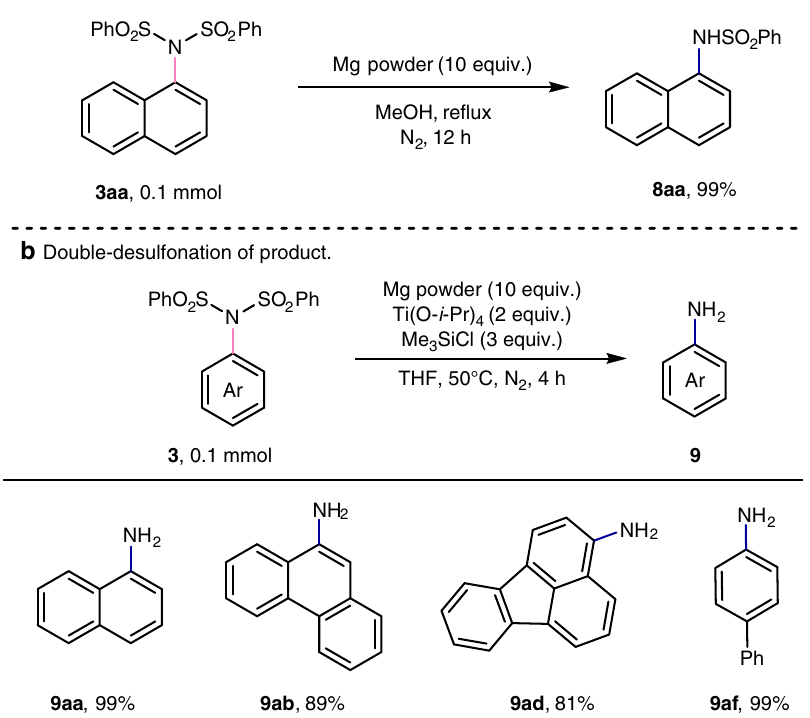
Fig. 6 Deprotection of arylimines. a Mono-desulfonation of the product. b Double-desulfonation of the